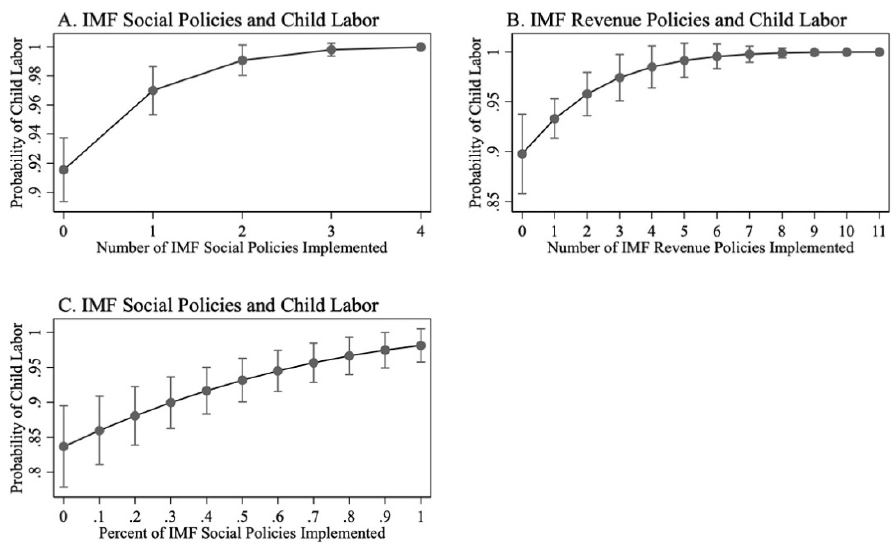
Figure 1. IMF Compliance and child labor predictions 95% CI.